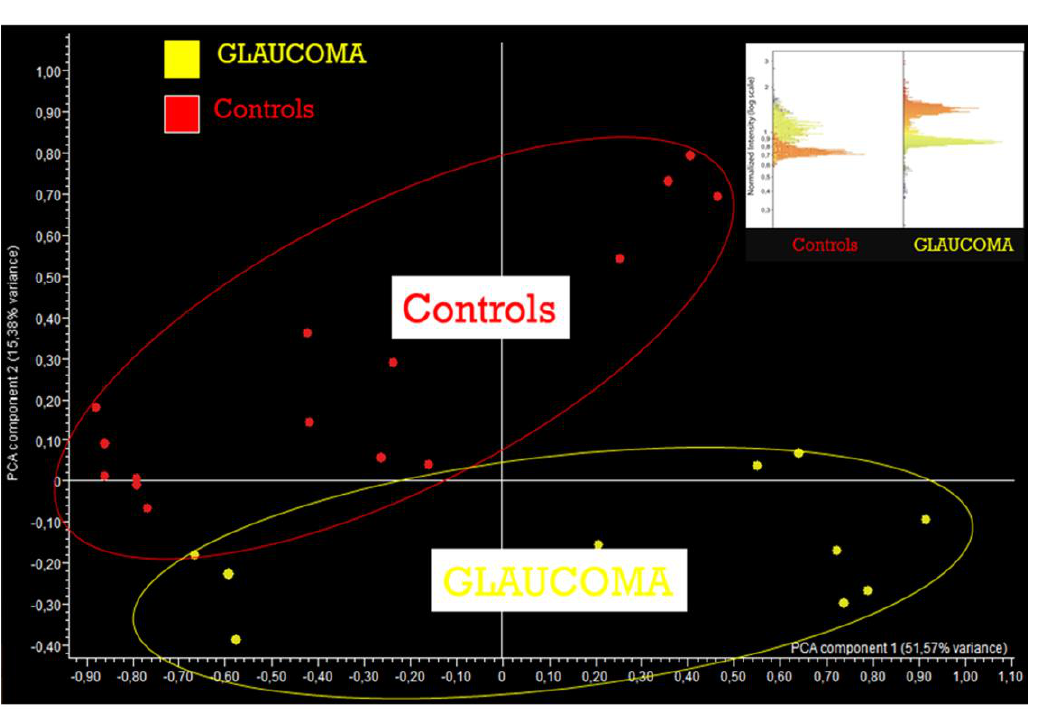
Figure 1. Glaucoma is a disease where pro-apoptotic signals that develop reach the head of the optic nerve promoting the death of ganglion cells. The aqueous pattern of these subjects reveals the very evident qualitative changes in proteome. This figure shows the results performed by ANTIBODY MICROARRAY in a glaucomatous AH sample. It is probable that these TM-derived proteins, released by damaged TM in the AH, may become biological signals for the retina and, in particular, for the ONH. POAG can occur with both a normal (i.e., 15–20 mmHg) or high IOP. The first one is also known as Normal-Tension Glaucoma (NTG), while the second is called High-Tension Glaucoma (HTG). In